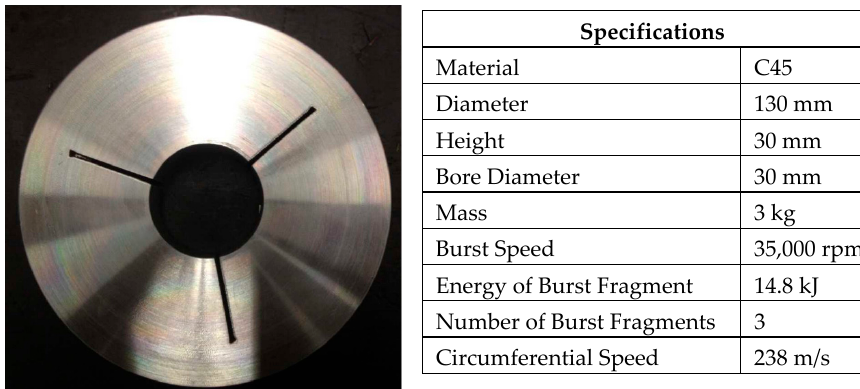
Figure 7 . Initial burst rotor design and relevant properties. Figure 7. Initial burst rotor design and relevant